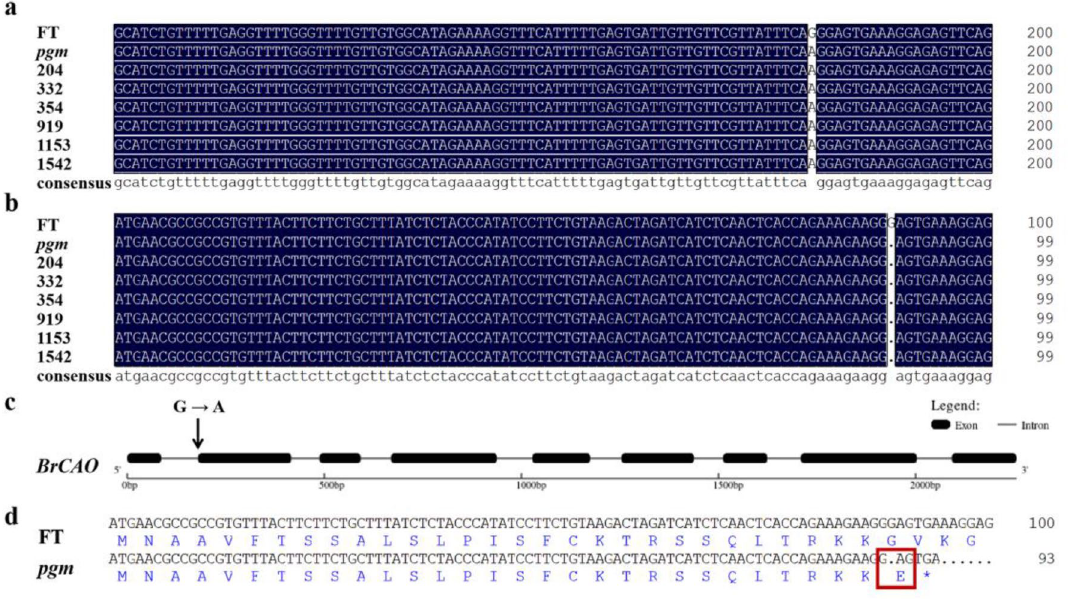
Figure 4. Sequence alignment and gene structure. ( a ) DNA sequence alignment of wild-type (FT), pale green mutant ( pgm ), and F 2 recombinant individuals: 204, 332, 354, 919, 1153, and 1542. ( b ) cDNA sequence alignment of FT, pgm , and F 2 recombinant individuals. ( c ) Gene structure of BrCAO . ( d ) BrCAO protein sequence of FT and pgm . The red box indicates the mutation position.